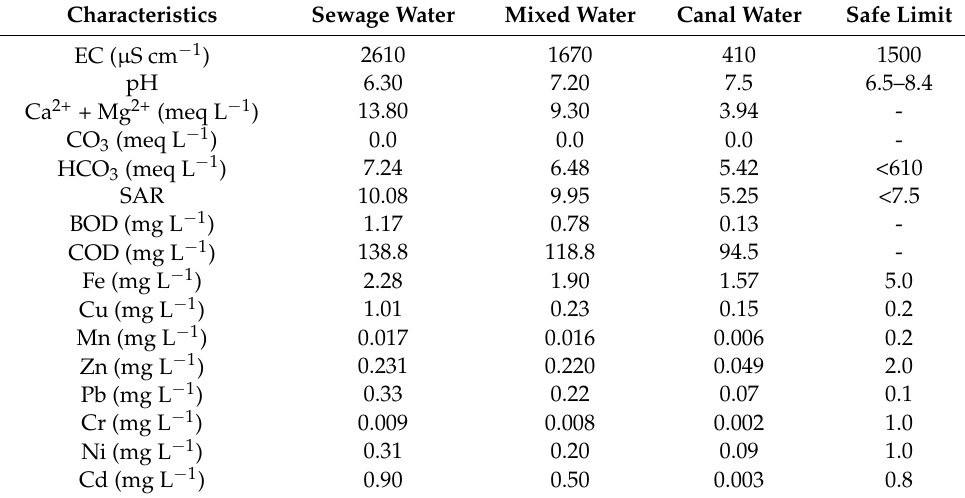
Table 2. Characteristics of the water sources applied in a pot